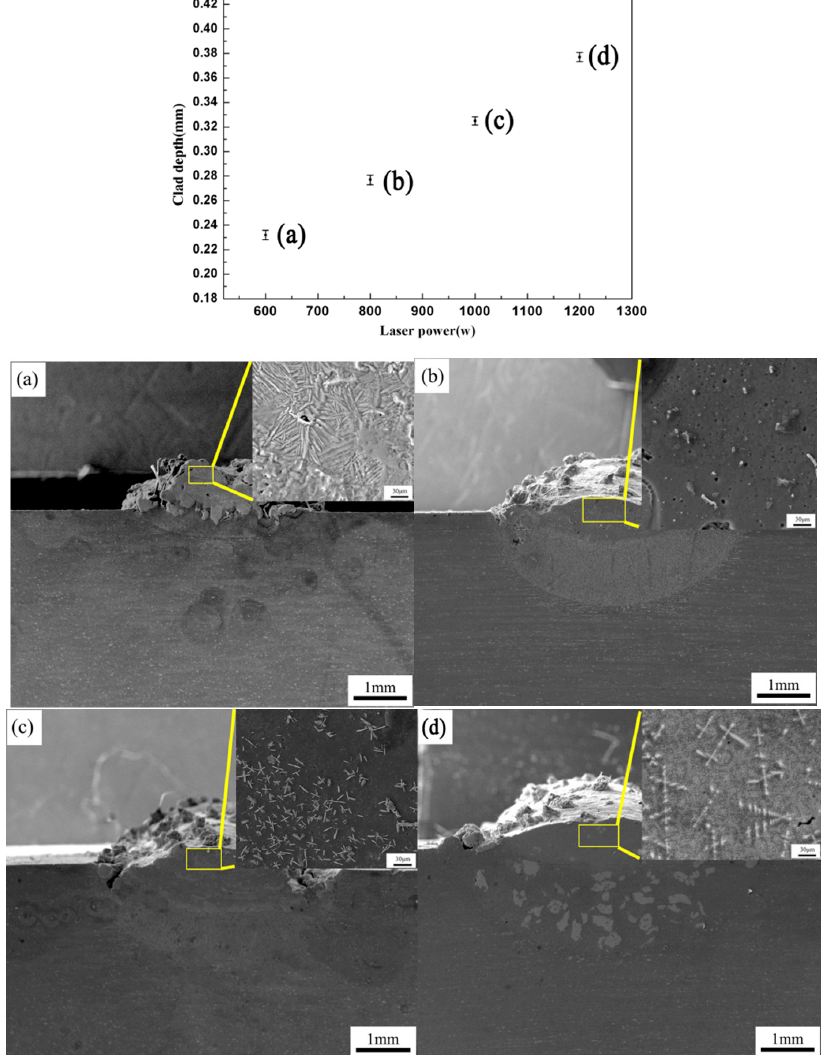
Figure 7. The effect of different laser power on the clad depth and microstructure at different laser power (P). ( a ) The laser power of 600 W; ( b ) the laser power of 800 W; ( c ) the laser power of 1000 W; ( d ) the laser power of 1200 W.